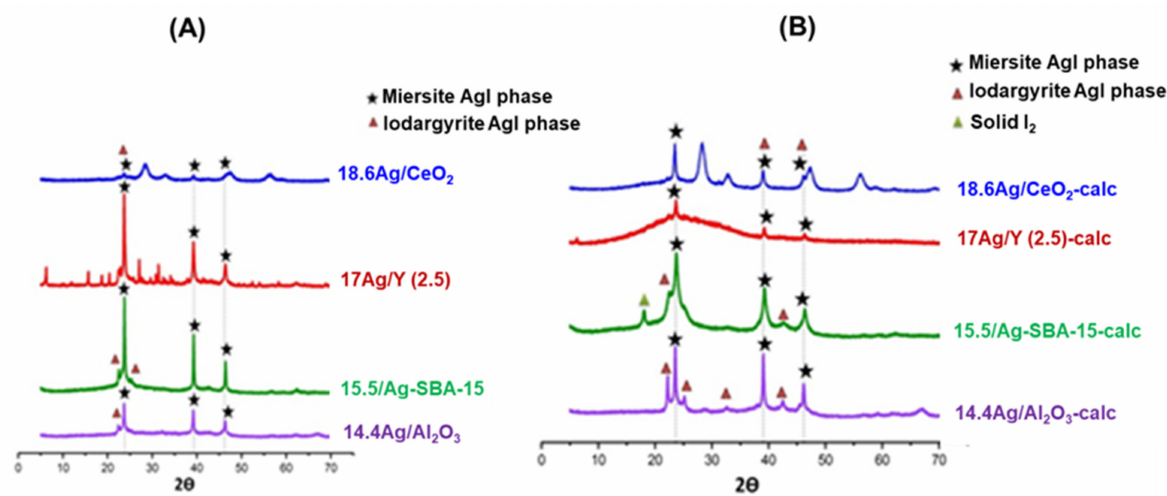
Figure 5. X-ray diffractograms of silver-impregnated adsorbents after I 2 adsorption test: ( A ) samples dried at 80 ◦ C, ( B ) samples calcined at 500 ◦ C (1